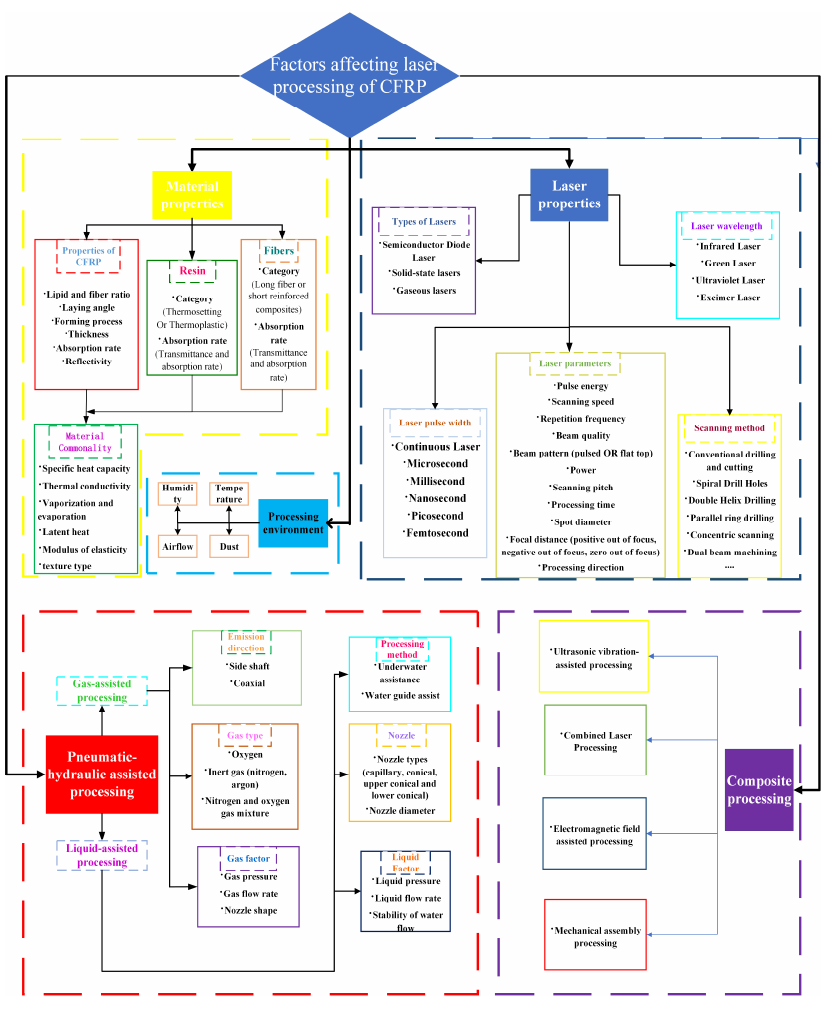
Figure 1. Influencing factors of CFRP laser processing.